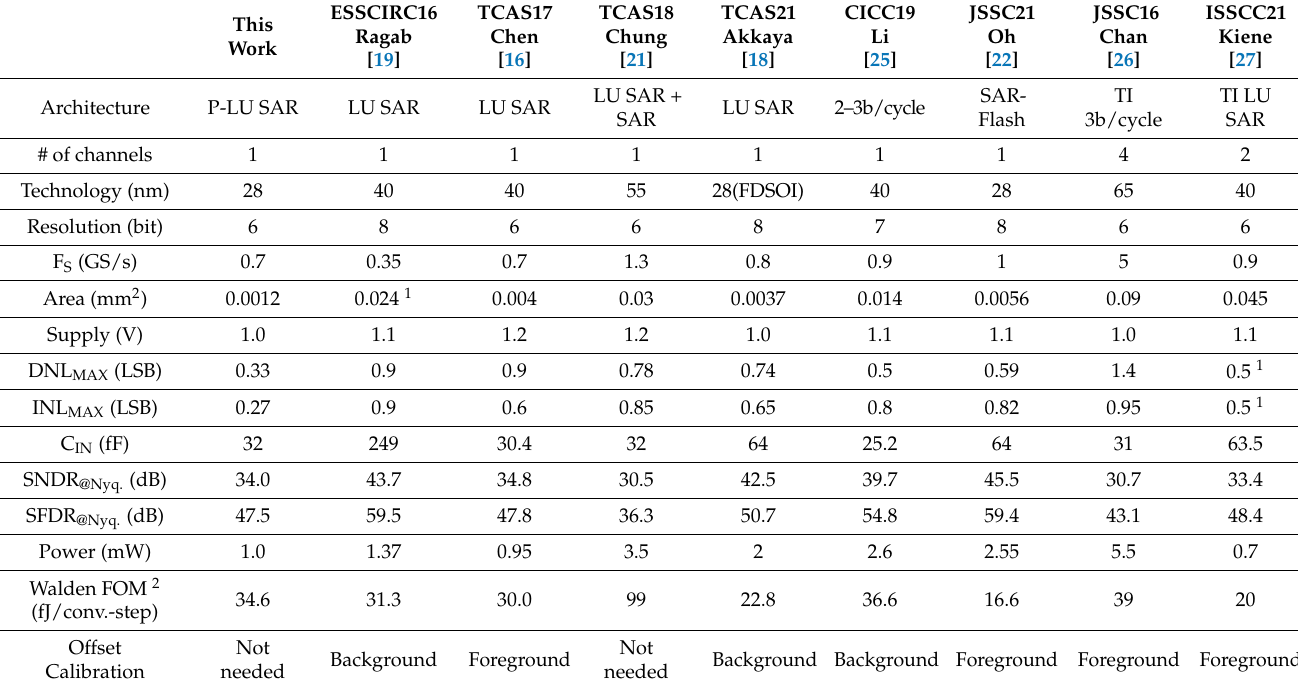
Table 2. Performance